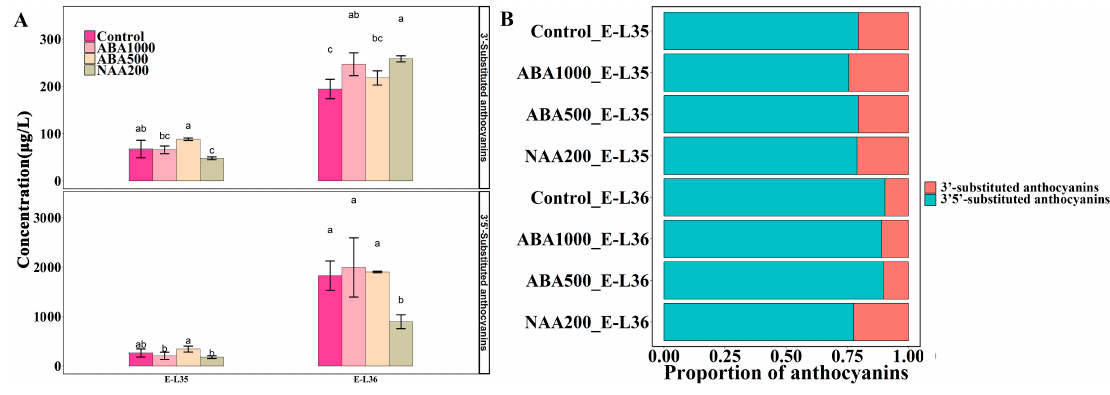
Figure 9. E ff ects of the treatments on the 3’-substituted anthocyanins and 3’5’-substituted anthocyanins: Figure 9. Effects of the treatments on the 3’-substituted anthocyanins and 3’5’-substituted ( A ) changes in their concentrations and ( B ) proportions. Di ff erent letters indicate significant di ff erences anthocyanins: ( A ) changes in their concentrations and ( B ) proportions. Different letters indicate ( p = significant differences ( p = 0.05).